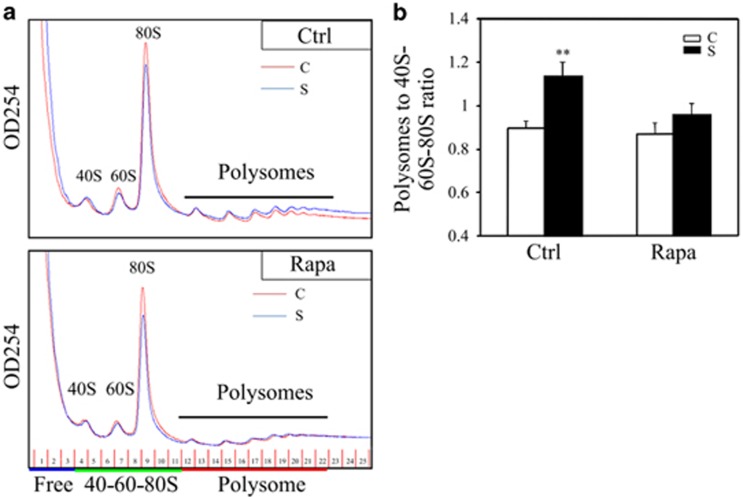
Rapamycin treatment inhibits the increase in global translation after ovarian surgery. Ovaries were collected 6 h after the operation. (a) Polysome profiles of control (C) and surgically treated (S) ovaries with or without injections of rapamycin. (b) The polysome/40S-60S-80S ratio was quantified by measuring the areas under the polysome and 40S-60S-80S peaks. Three independent experiments were performed. Data are presented as means±SEM; **P<0.01, showing the significant increase in translation by operated ovaries compared with control, non-operated ovaries